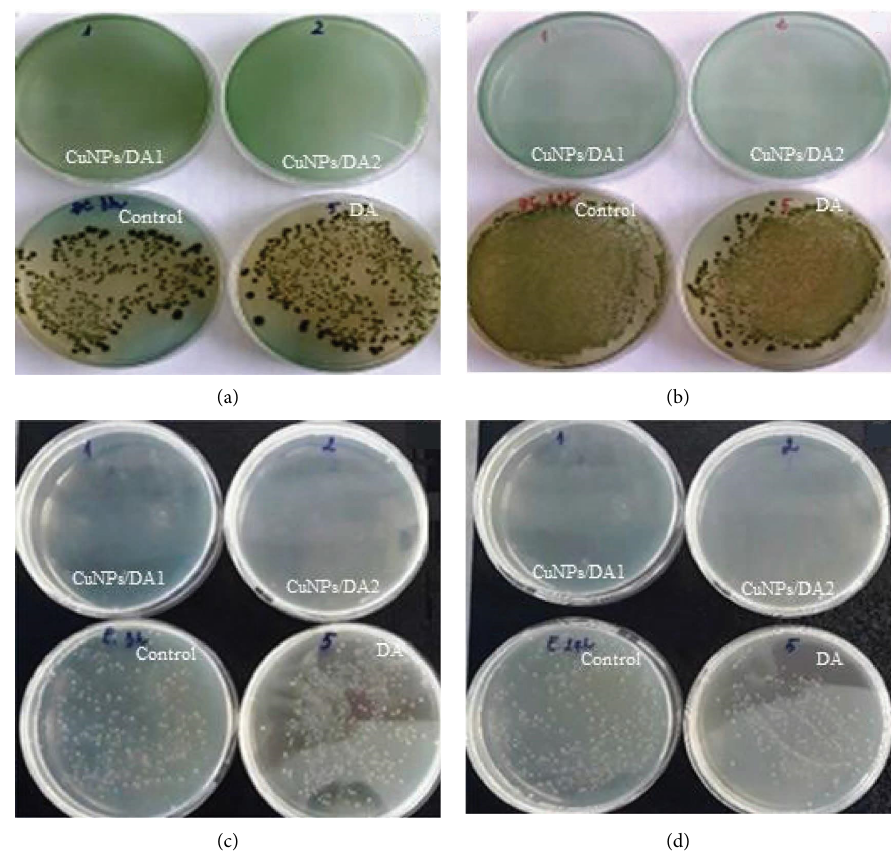
Figure 5: Photographs of antibacterial results against A. hydrophila (a, b) and Ed. ictaluri (c, d) after 3h and 24h contact of control, DA, and